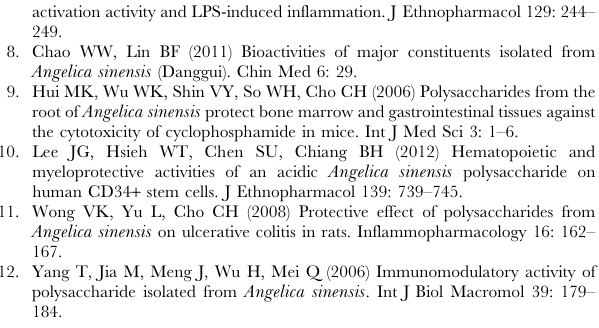
(Nikon, Tokyo, Japan). Values are presented as mean 6 SEM from at least three independent experiments. * P , 0.05, ** P , 0.01 (TIF) Figure S2 Insulin like growth factor 1 (IGF1) stimulated glycosaminoglycan (GAG) synthesis of human primary chondrocytes. Chondrocytes were treated with IGF-1 (2, 10 and 50 ng/ml) or IL-1 b (10 ng/ml) alone for 48 h, respectively. Meanwhile, chondrocytes were pre-treated with IL-1 b (10 ng/ml) for 30 min and then co-treated with IL-1 b and IGF-1 (2, 10 and 50 ng/ml) for another 48 h. Then, 1,9-dimethylmethylene Blue was applied to detect the GAG of chondrocyte cultures. Values are presented as mean 6 SEM from at least two independent experiments. * P , 0.05, ** P , 0.01 versus control group; # P , 0.05, ## P , 0.01 versus IL-1 b group. (TIF) Figure S3 Effects of Angelica sinensis polysaccharides (APS-3c) on the ultrastructure of human primary chondrocytes. A, Control group; B–D, Chondrocytes treated with 2, 10 and 50 m g/ml APS-3c for 48 h; E, Chondrocytes induced by 10 ng/ml IL-1 b for 48 h;F–H, Chondrocytes pre- treated with 10 ng/ml IL-1 b for 30 min and then co-treated with IL-1 b and 2, 10 and 50 m g/ml APS-3c for 48 h. All photographs were taken at an original magnification of 15,000. N, nucleus;M, mitochondrion; rER, rough surfaced endoplasmic reticulum; G, Golgi apparatus; V, vacuole; AV, autophagic vacuole; SV, secretory vesicle. (TIF) Figure S4 Effects of Angelica sinensis polysaccharides (APS-3c) on cell viability of human primary chondro- cytes. Chondrocytes were treated with 2, 10 and 50 m g/ml APS- 3c for 48 h or pre-treated with IL-1 b (10 ng/ml) for 30 min, and then co-treated with IL-1 b and APS-3c (2, 10 and 50 m g/ml) for 48 h. Values are presented as mean 6 SEM from at least three independent experiments. * P , 0.05 versus control